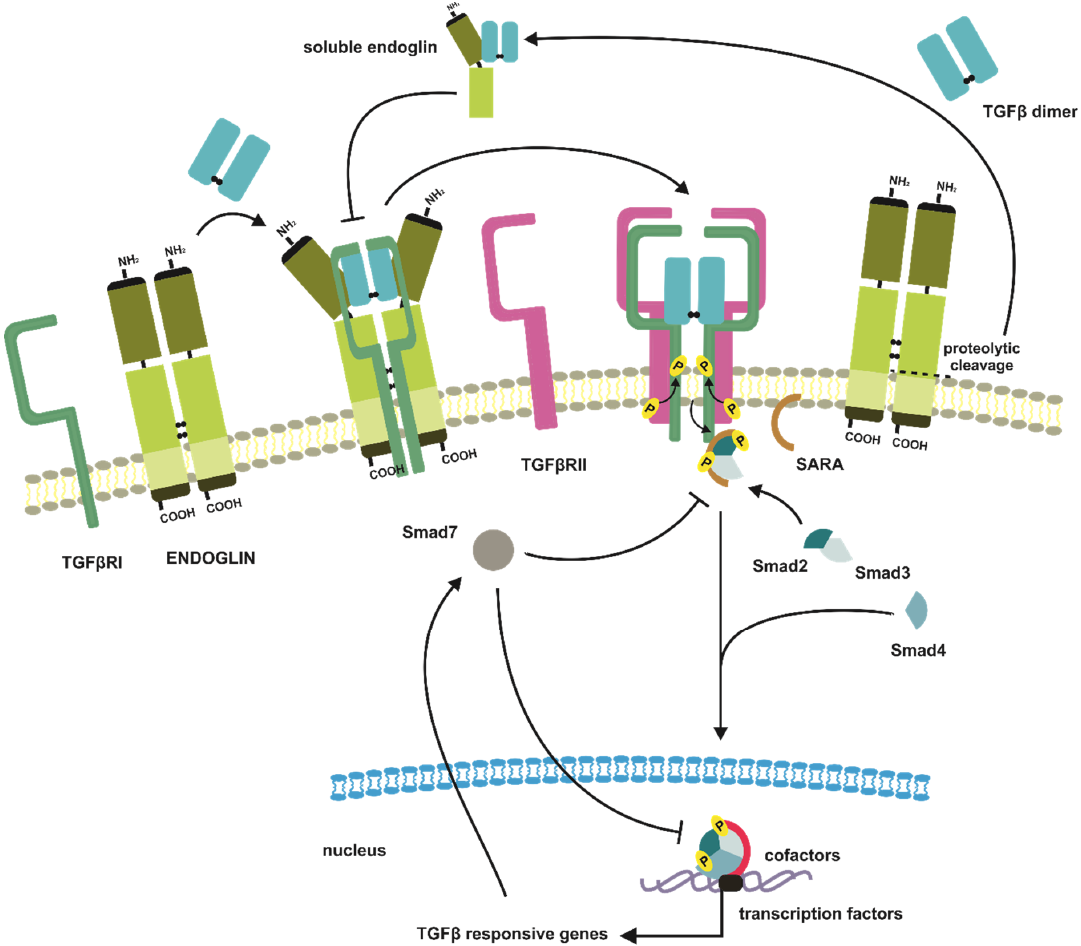
Figure 6. Canonical TGF β signaling mediated by TGF β co-receptor endoglin and soluble endoglin formed after proteolytic cleavage. In the case of endoglin, TGF β dimers binding results in endoglin conformational changes, with sequential facilitation of TGF β RIs attachment, and endoglin dimer replacement with TGF β RIIs. Endoglin can also modulate TGF β signaling due to its ectodomain shedding. A soluble endoglin effectively sequestrates TGF β dimers, thus diminishing pathway activation.